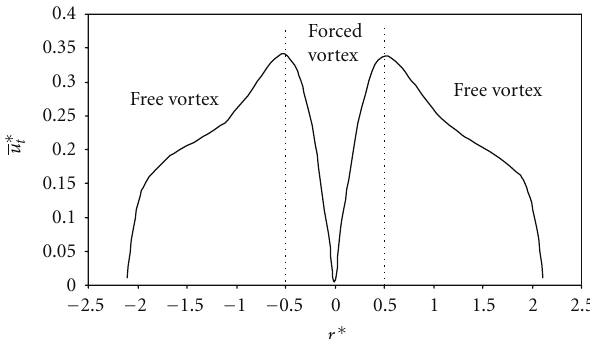
Figure 15: Computational mean tangential velocity profile.